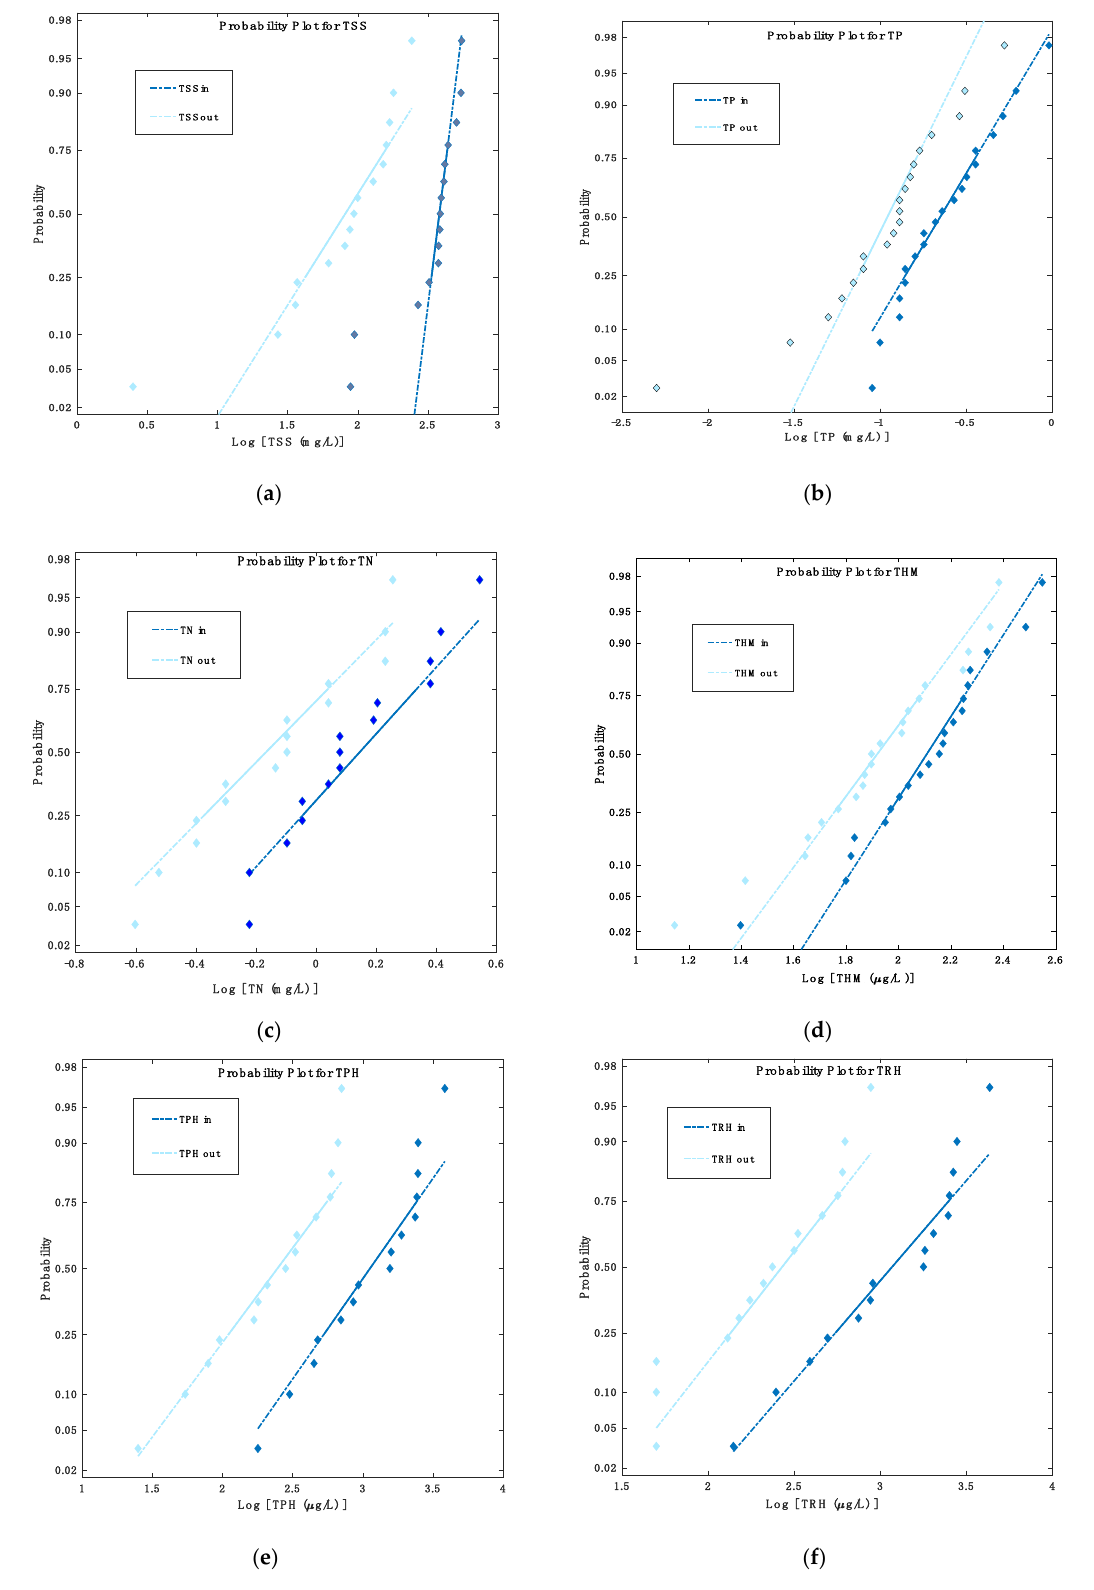
Figure 6. Probability plots for pollutants: ( a ) TSS; ( b ) total phosphorous (TP); ( c ) total nitrogen (TN); ( d ) total heavy metals (THM); ( e ) total petroleum hydrocarbons (TPH); ( f ) total recoverable hydrocarbons (TRH).